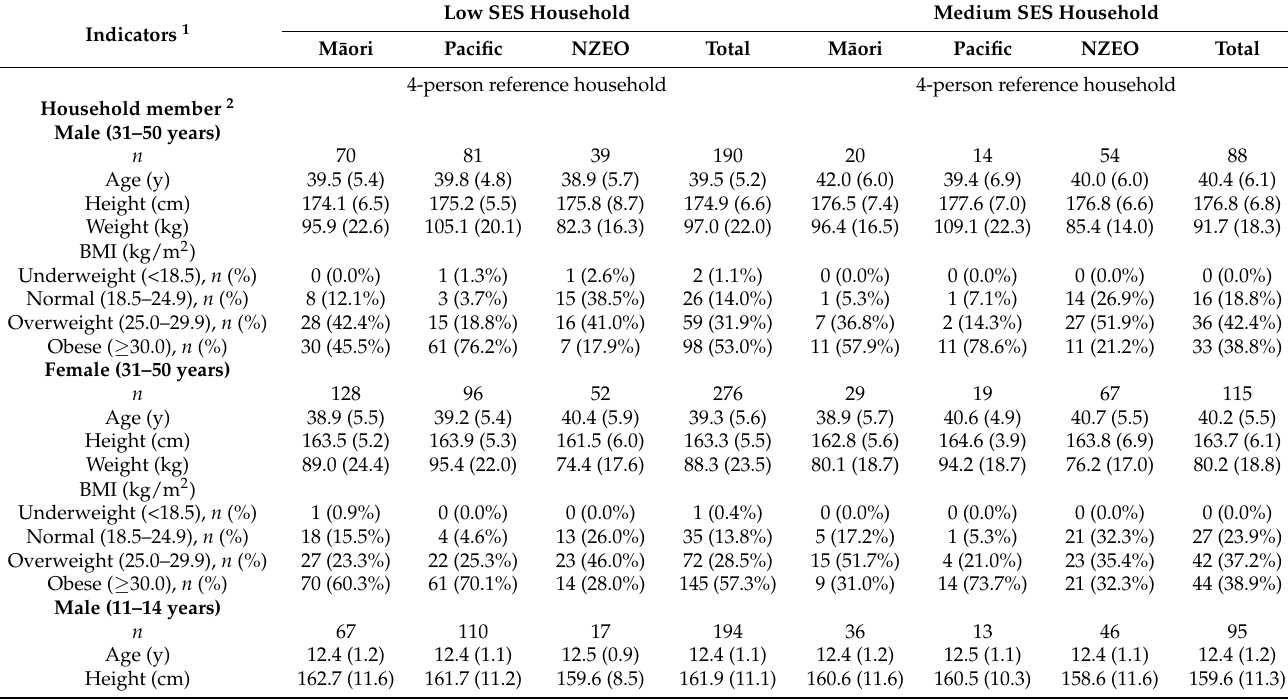
Table 1. Characteristics of low and medium SES reference households, for M¯aori, Pacific, and NZEO ethnic groups, as well as the total